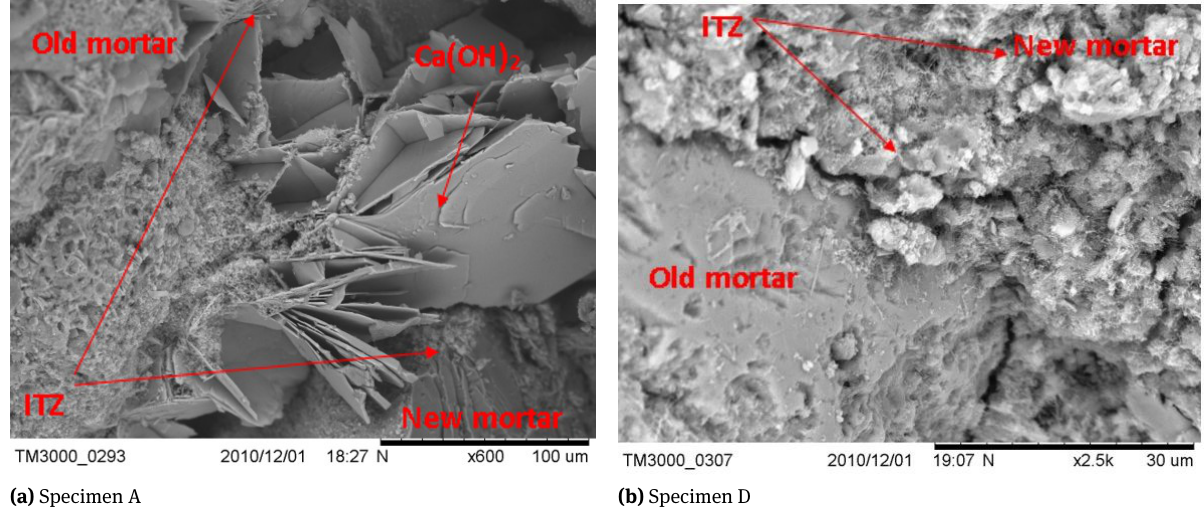
Figure 10: SEM images of ITZ between old mortar and new mortar in specimen A and D